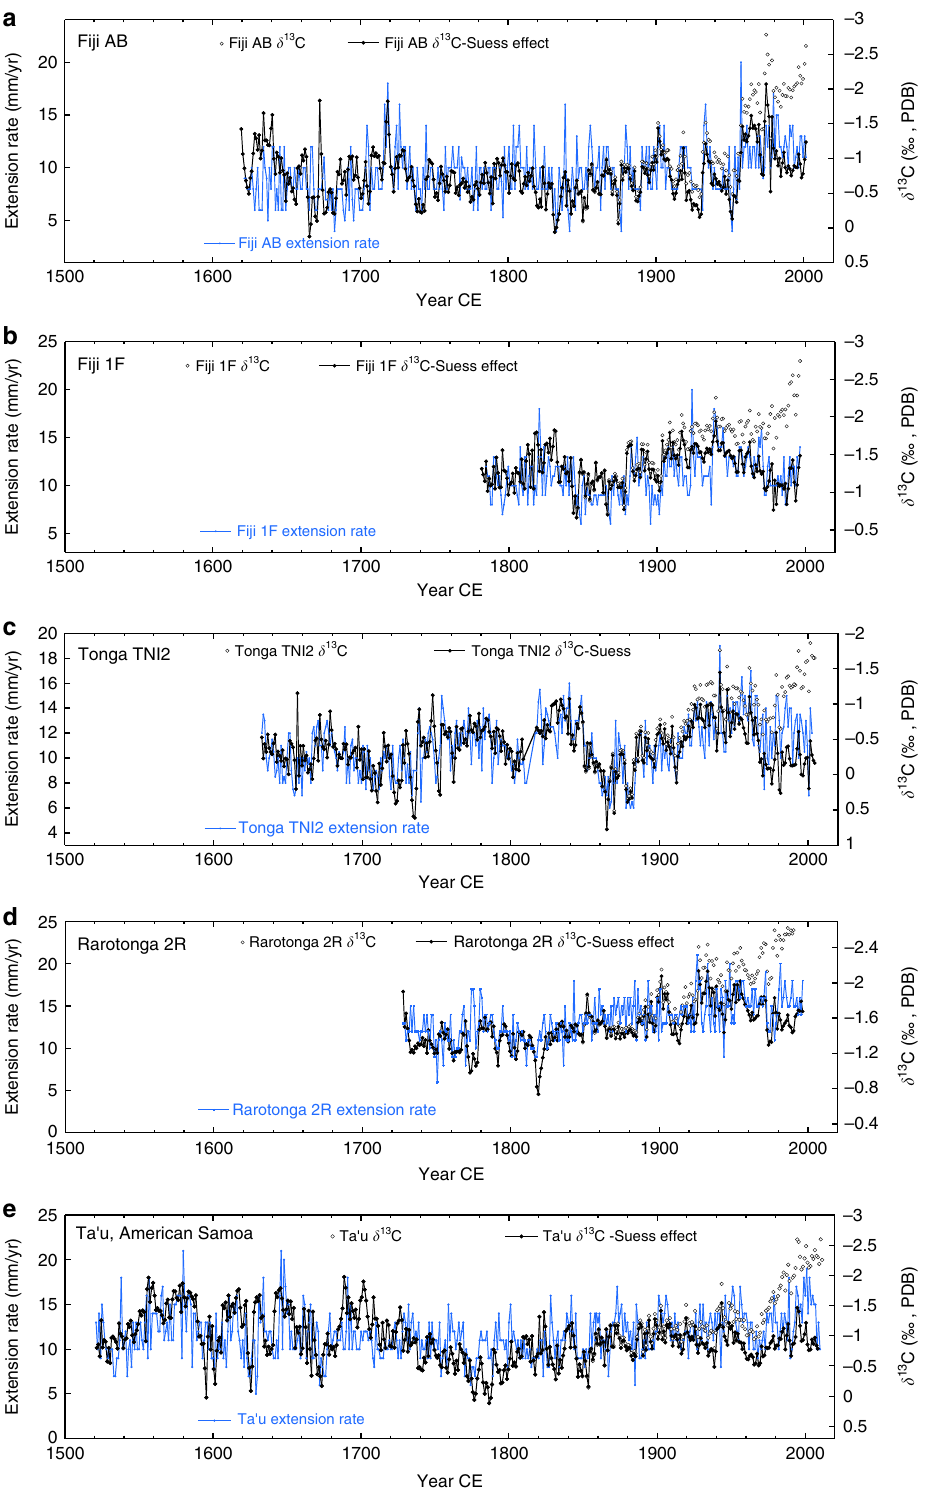
Fig. 3 South Paci fi c coral δ 13 C and skeletal extension rate: coral annual skeletal extensions rates (in blue) and annual average skeletal δ 13 C (black open dots) and δ 13 C data with the average atmospheric 13 C Suess effect removed (solid black dots) in Porites lutea corals from: a Fiji core AB 53 , b Fiji core 1F 52 , c Tonga core TNI2 54 , d Rarotonga core 2R 51,52 , and e American Samoa core Ta ’ u-1 55,56 . Extension rate and δ 13 C signi fi cantly correlate to varying degrees (see R values in Table 1) up until the mid-20th century when coral δ 13 C abruptly shifts ~1.0 ‰ lower at all of these sites. The very low growth year in 2000 in Tonga core TNI2 is a con fi rmed bleaching event when growth was truncated to 7 mm in that year. Also note that Fiji cores 1F and AB were collected from Porites lutea colonies in Savusavu Bay at the same water depth approximately 100 m from each other. Source data are provided as a Source Data fi le in